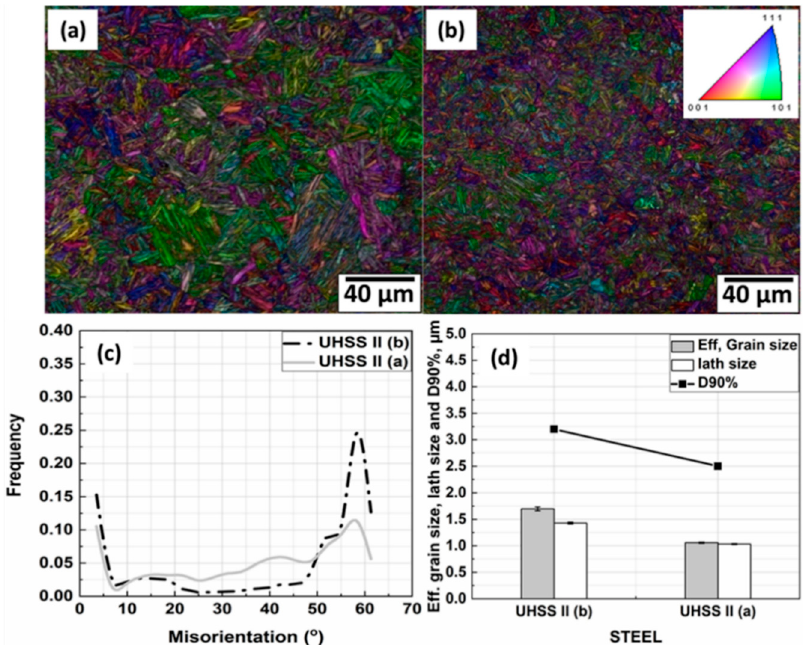
Figure 7. IPF with superimposed IQ map of forged and air-cooled bar of UHSS II without ESR ( a ) and with ESR ( b ) (scale bar is 40 µm), grain boundary misorientations ( c ), mean lath size, mean effective grain size and D90% ( d ).